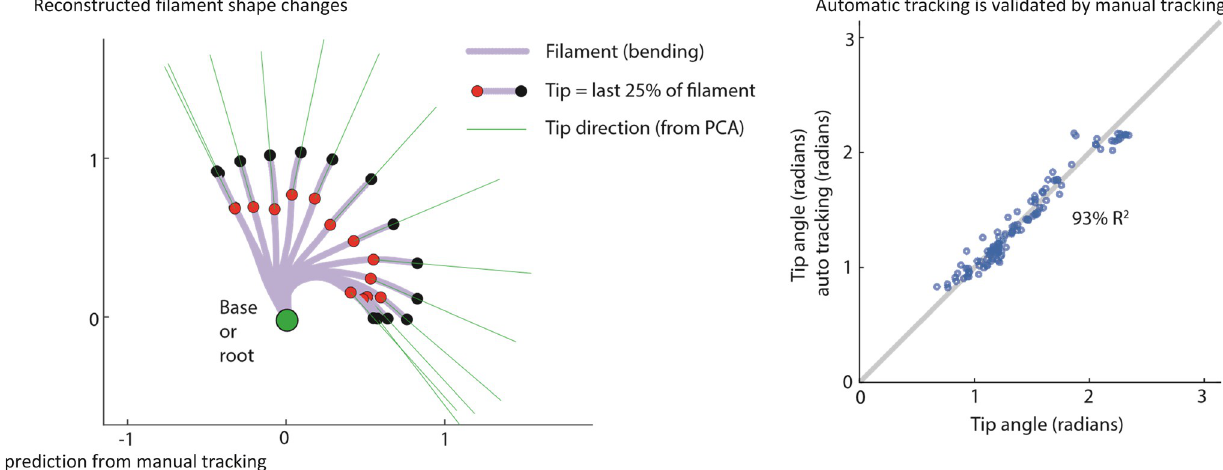
Fig 3. Validating automatic filament tracking. (A) Automatically reconstructed filament shape changes are shown for one trial. The final 25% of the filament length, labeled by the red and black solid circles are used to compute the tip direction (green). (B) Automatic computer-vision-based tracking the filament agrees well with manual tracking of the